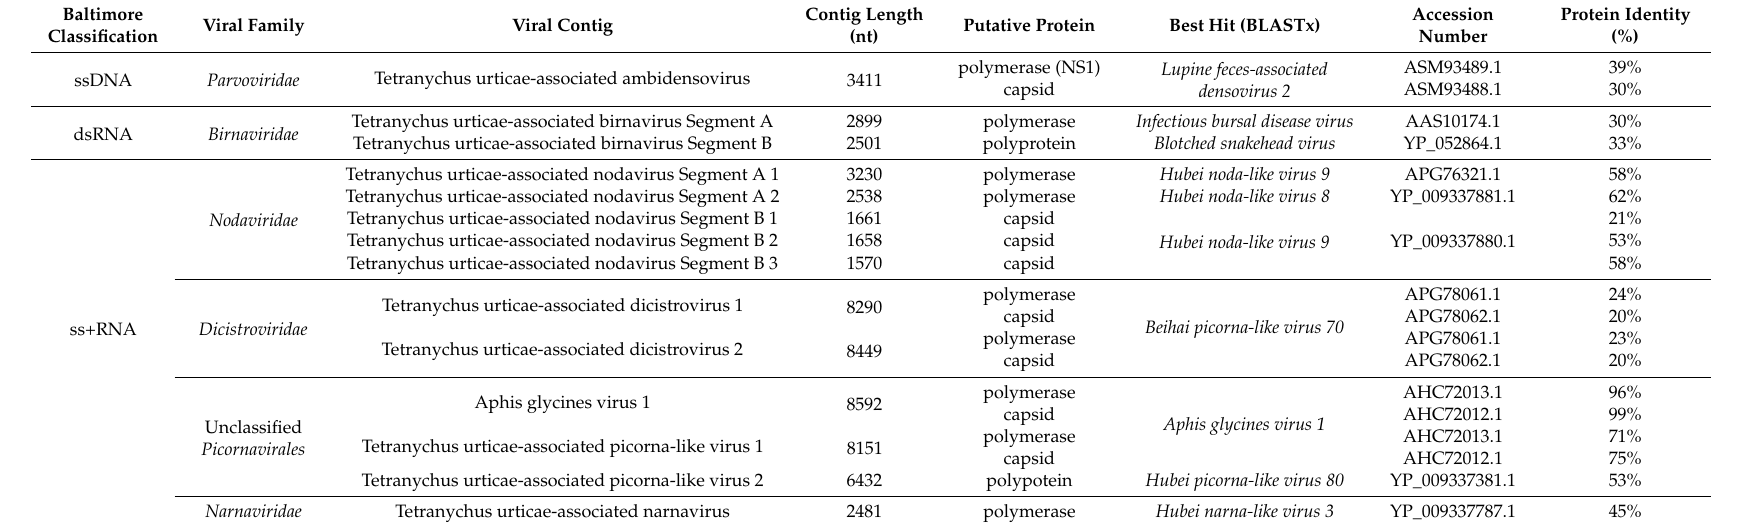
Table 1. Description of the fourteen virus contigs found in T. urticae viromes and protein identity comparison with their closest relatives. Baltimore